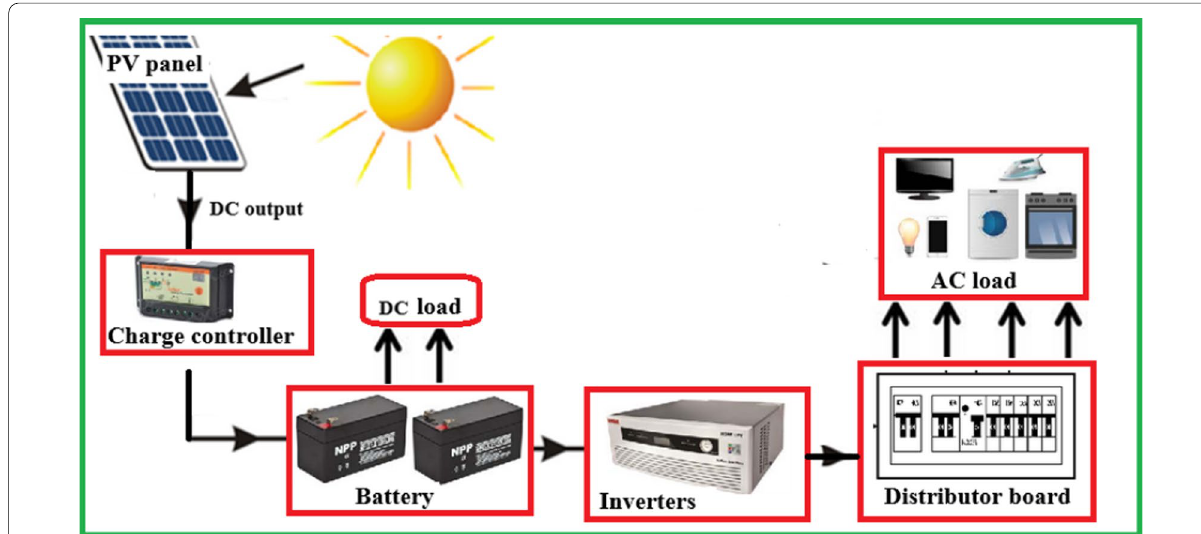
Fig. 2 Main components of a stand-alone solar PV